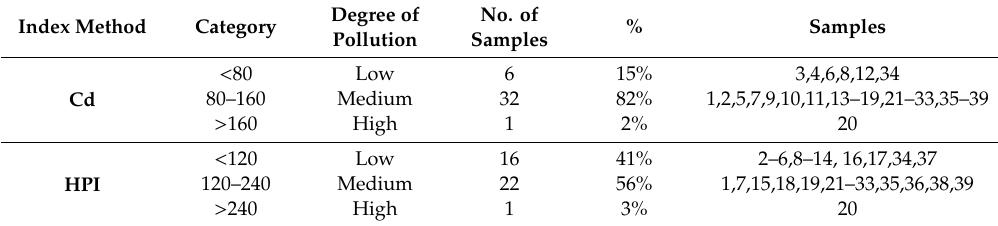
Table 6. Classification of groundwater quality of the study area on modified categories of pollution indices.